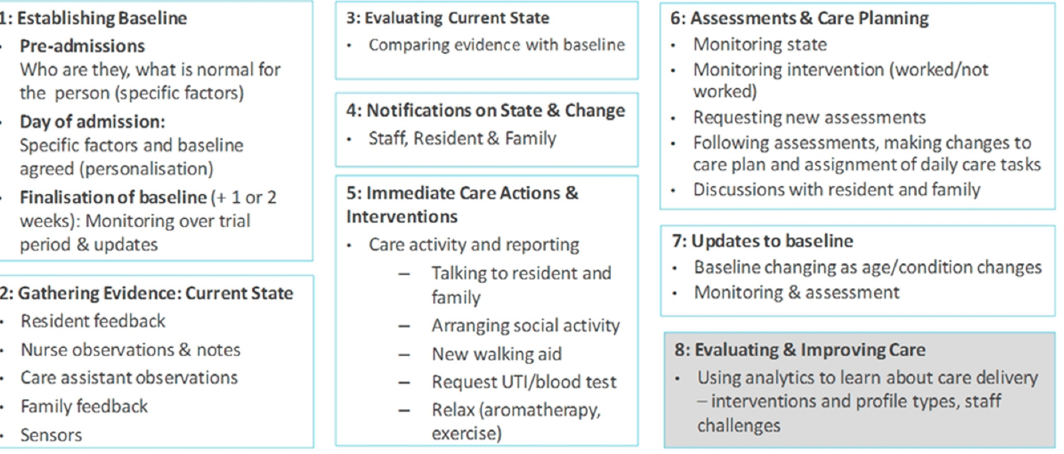
Figure 3. Process flow for monitoring/managing (1) resident wellness, (2) resident environment and (3) care